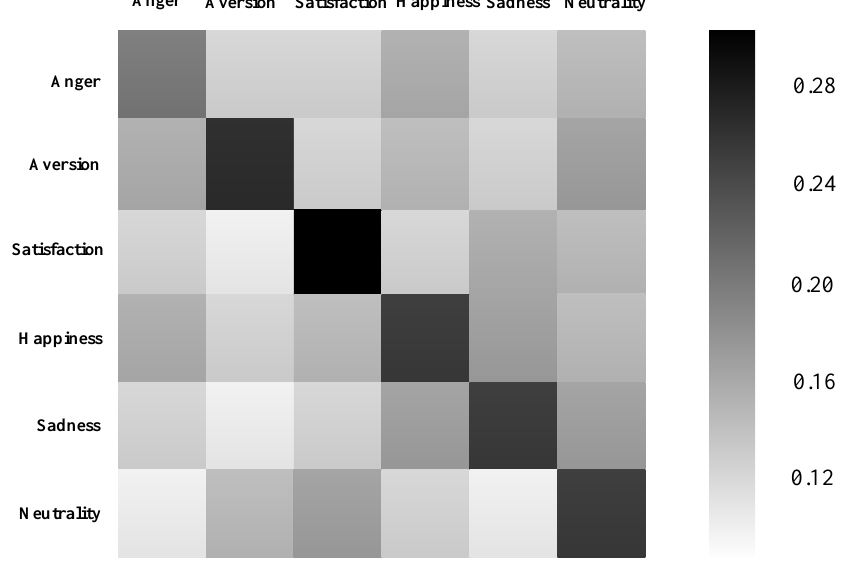
Figure 4. The emotional interaction pattern (EIP).